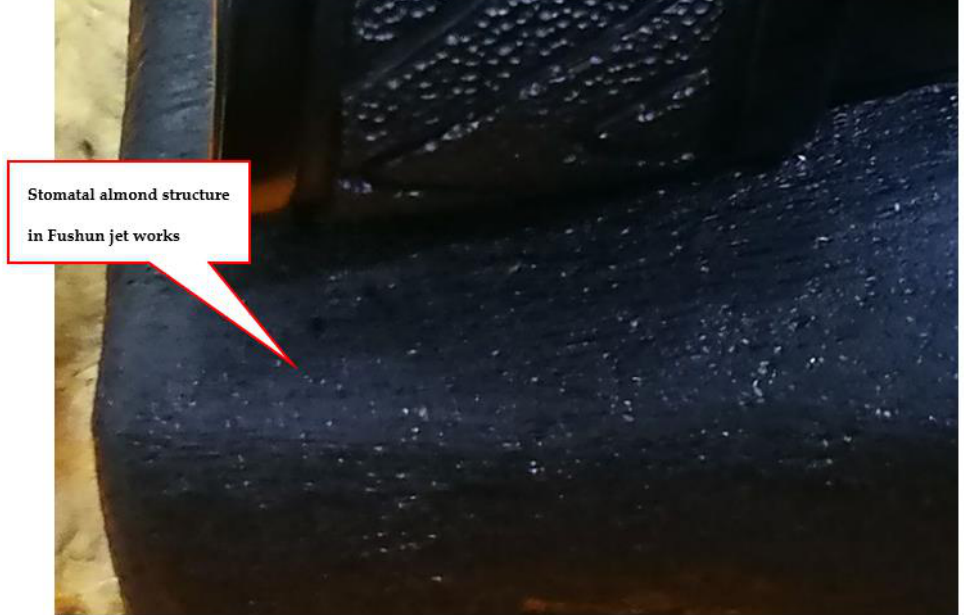
Figure 4. Stomatal almond structure in Fushun jet works.